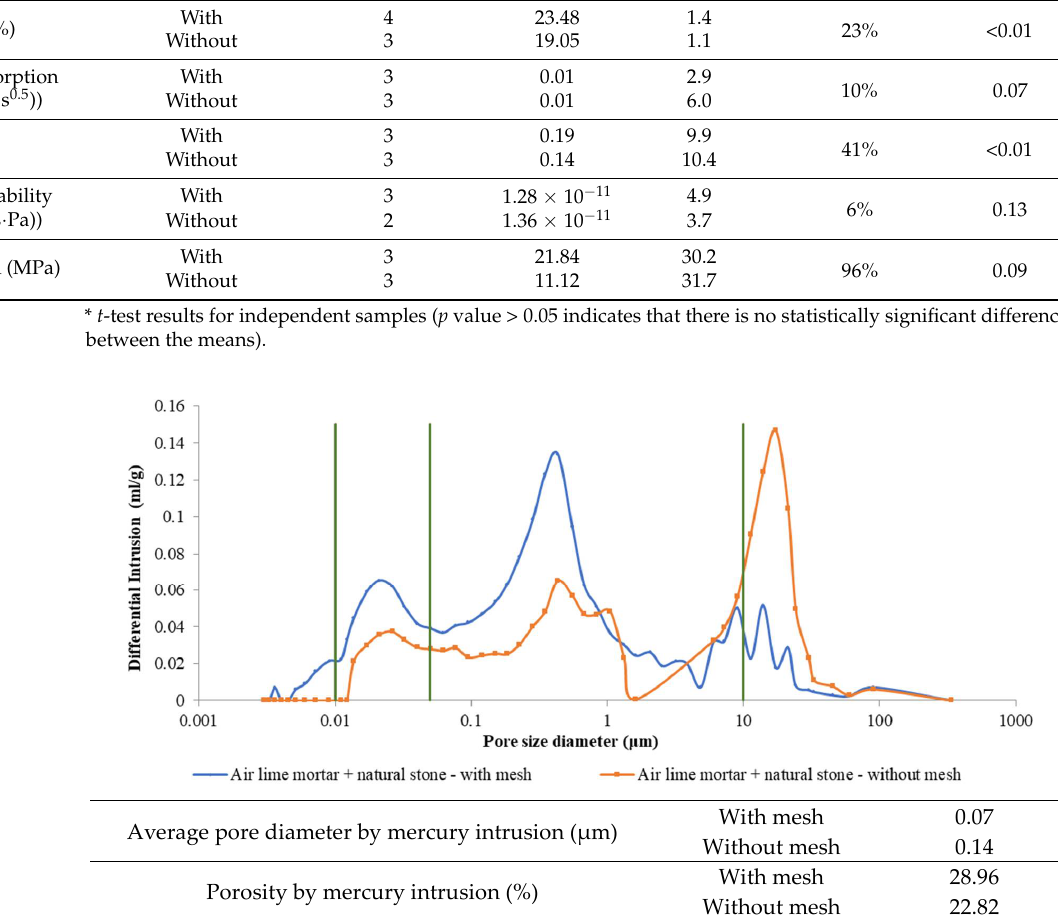
Figure 14. Porosimetry properties obtained by mercury intrusion of air lime mortar applied to natural stone substrate, with and without mesh. Table 14. Air lime mortars–capillary pores–cumulative mercury intrusion. Sample